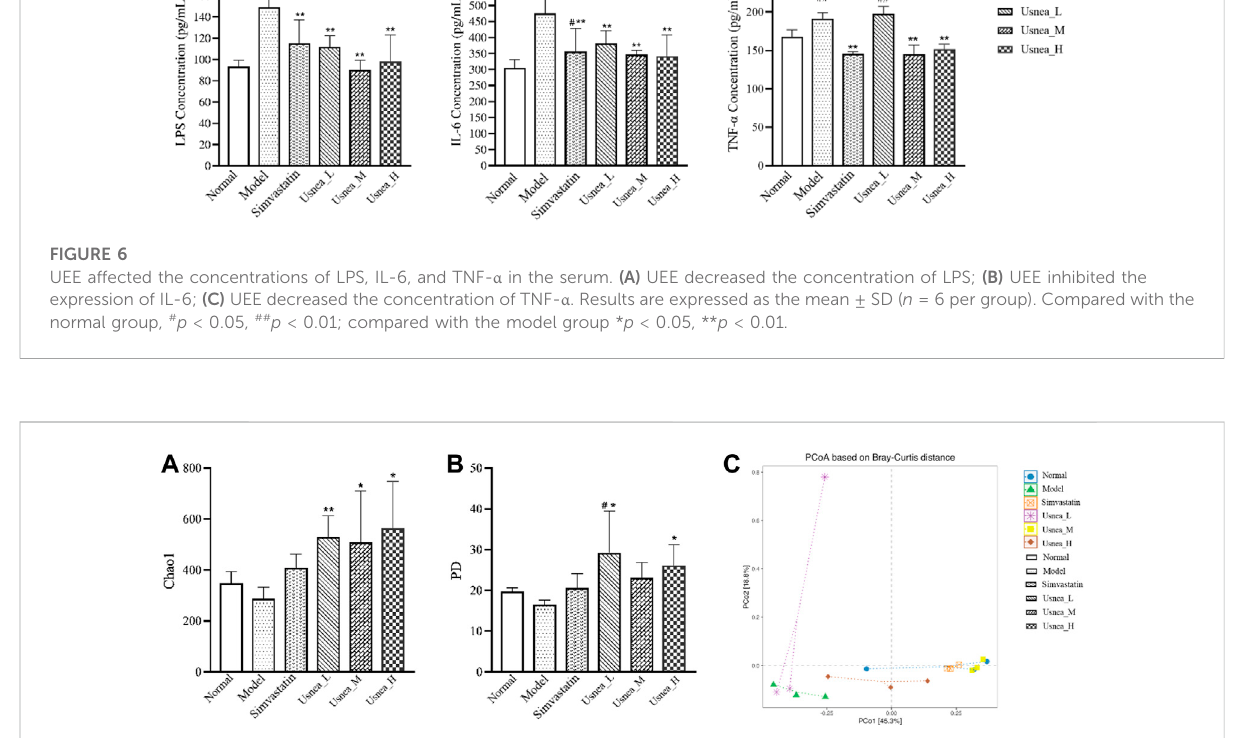
FIGURE 7 Intestinal fl ora alpha diversity index. (A) Chao1; (B) Faith ’ s phylogenetic diversity; (C) Beta diversity of AS rats, including PCoA. Results are expressed as the mean ± SD ( n = 3 per group). Compared with the normal group, # p < 0.05; compared with the model group, * p < 0.05, ** p <